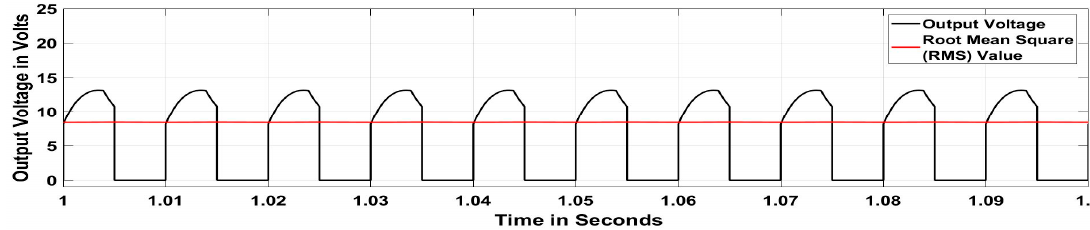
Figure 11. Simulated output of DC–DC buck mode load voltage.